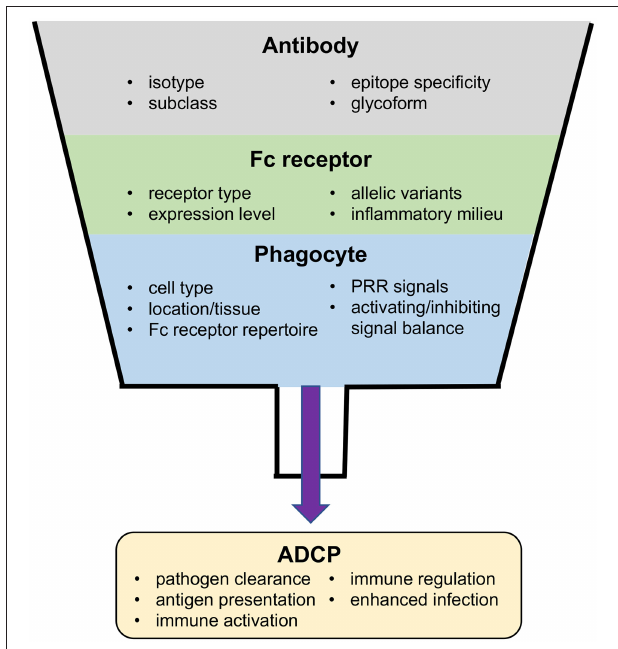
FIGURE 2 | Factors impacting ADCP and potential outcomes of the ADCP response to virus